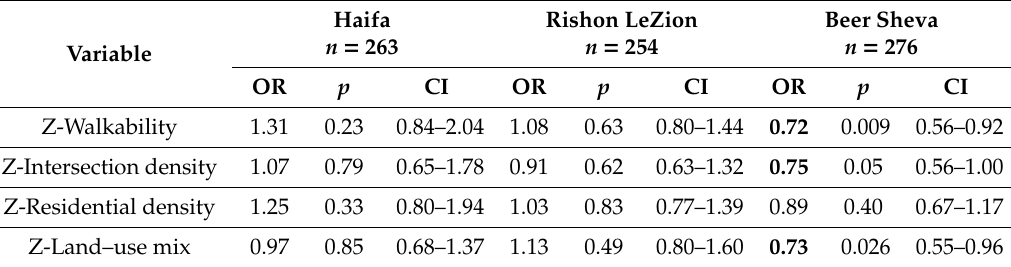
Table 4. Multivariable logistic regression models to predict adolescents’ BMI in each city by the built environment measures and controlled for area SES, gender, PA, sedentary behavior and nutritional home environment. Haifa Rishon LeZion Beer Sheva n = 263 n = 254 n = 276 Variable OR p CI OR p CI OR p CI Z-Walkability 1.31 0.23 0.84–2.04 1.08 0.63 Z-Intersection density 0.33 Bold numbers represent significant